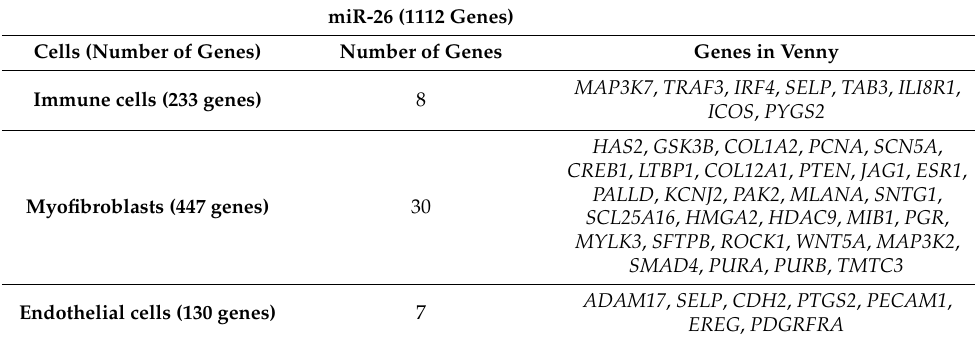
Table 5. Genes controlled by miR-26 and involved in the biology of immune, myofibroblast and endothelial